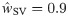
Mismatch detection by SOM/VIP-dependent amplification.(A) Additional modulatory input onto SOM neurons shifts the transition point (green) of the PC rate as a function of modulatory VIP input (top). When plotted as a function of the difference of SOM and VIP input, the transition points align, indicating that the circuit amplifies differences between two input streams (bottom). Additional input onto SOM neurons ranges from −2/s to 0/s. (B) Model for the integration of visual inputs and motor-related predictions [56]. SOM neurons, PV neurons and the somatic compartment of PCs receive external visual input, VIP neurons and the apical dendrites of PCs receive an internal (motor-related) prediction of the expected visual input. The connection strengths from PV neurons to the somatic compartment of PCs and the SOM→PV connection were chosen to ensure a response only when the visual input is switched off and the (motor-related) prediction is switched on (see S1 Appendix for details). (C) PCs respond with an increase in firing rate when visual input is off and the motor-related input is on (mismatch), but show a negligible increase in activity above baseline when both input streams are on. (D) Also, only negligible responses above baseline are evoked when motor-related input is permanently off (playback session). w^SV=0.9, w^VS=1.1. (E) The mismatch-induced increase in firing rate is more pronounced in an amplification regime (w^SV=0.9, w^VS=1.1, dark red) in comparison to an attenuation regime (w^SV=0.1, w^VS=0.3, gray). Parameters (B-E): Motor-related and visual input on corresponds to an additional input of 10.5/s and noise drawn from a Gaussian distribution with zero mean and SD = 3.5/s. Background stimulation xE = 28/s, xD = 0/s. Time constant of PCs increased by factor 6 to reduce onset responses.